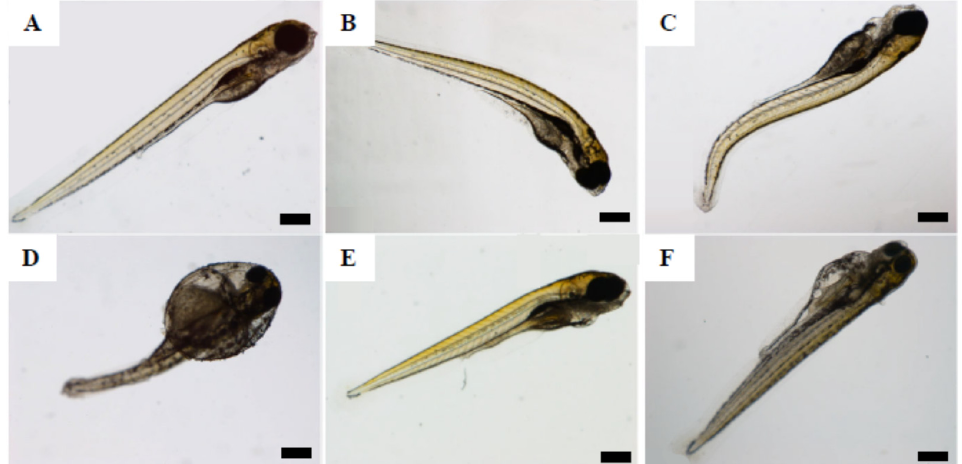
Figure 1. Malformations found in exposed zebrafish embryos at 120 hpf. ( A ) unexposed control embryo showing normal morphology; ( B ) embryo exposed to 0.687 mg/L of 500 nm NPs showing spinal cord flexure; ( C ) embryo exposed to 0.069 mg/L of 500 nm NPs-B(a)P showing pericardial edema and spinal cord flexure; ( D ) embryo exposed to 50.1 mg/L of 4.5 µm MPs-B(a)P showing multiple malformations, such as pericardial edema, yolk sac edema, and spinal cord flexure; ( E ) embryo exposed to 10 mg/L of B(a)P showing pericardial edema; ( F ) embryo exposed to 1 mg/L of B(a)P showing yolk sac edema. Scale bars: 100 µm.